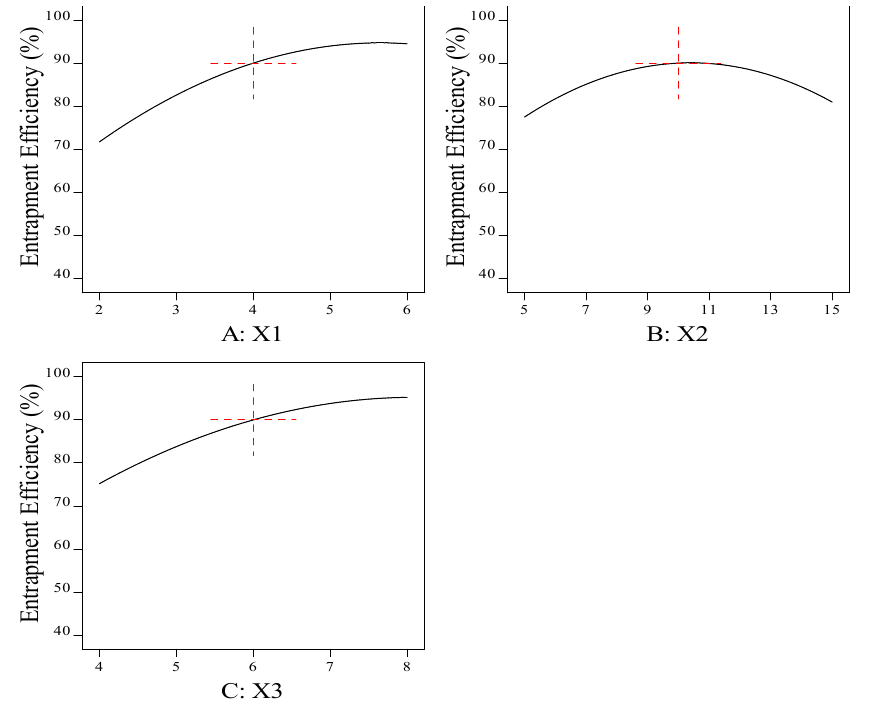
Figure 3. Main-effect plot for the effect of formulation factors (X1, X2, and X3) on the entrapment efficiency percentage (Y1). ( A ) Effect of sodium alginate concentration on the entrapment efficiency percentage (Y1); ( B ) effect of cross-linker concentration on the entrapment efficiency percentage (Y1); and ( C ) effect of sesame oil concentration on the entrapment efficiency percentage (Y1).